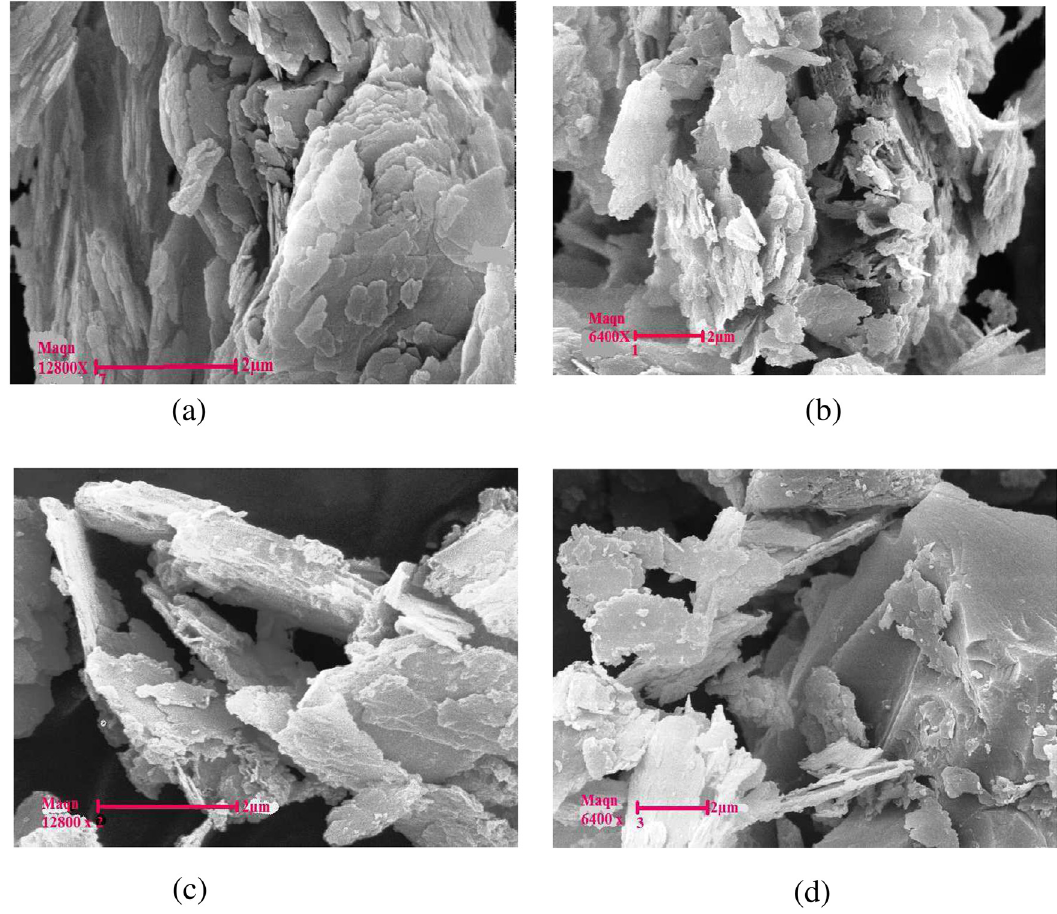
Figure 3: SEM images of ATMa clay ( a ) , GM1 ( b ) , GM2 ( c ) , GM3 ( d ) .